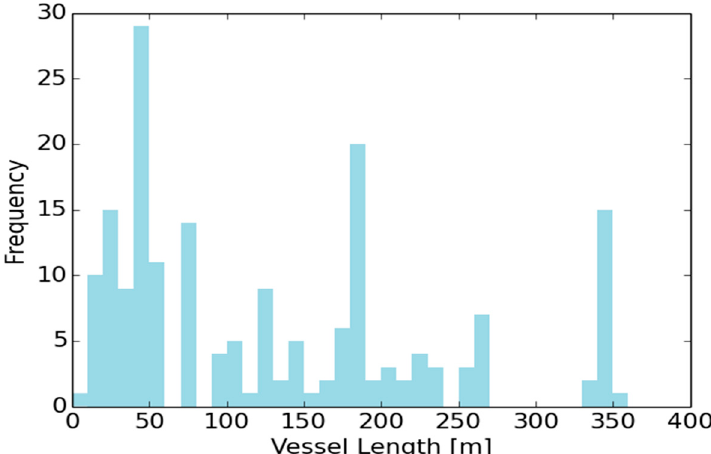
Figure 15. The lengths distribution of vessels reported by AIS but not detected in SAR data.